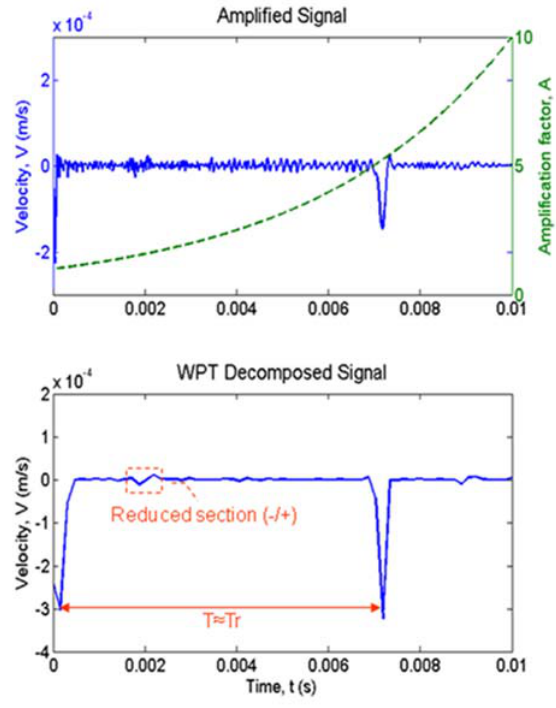
Figure 18. Amplified and WPT decomposed velocity signal for case g of dataset 2 (cylindrical void).